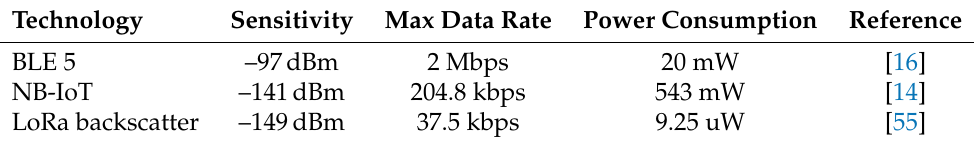
Table 4. Sensitivity level and maximum supported data rates for different IoT